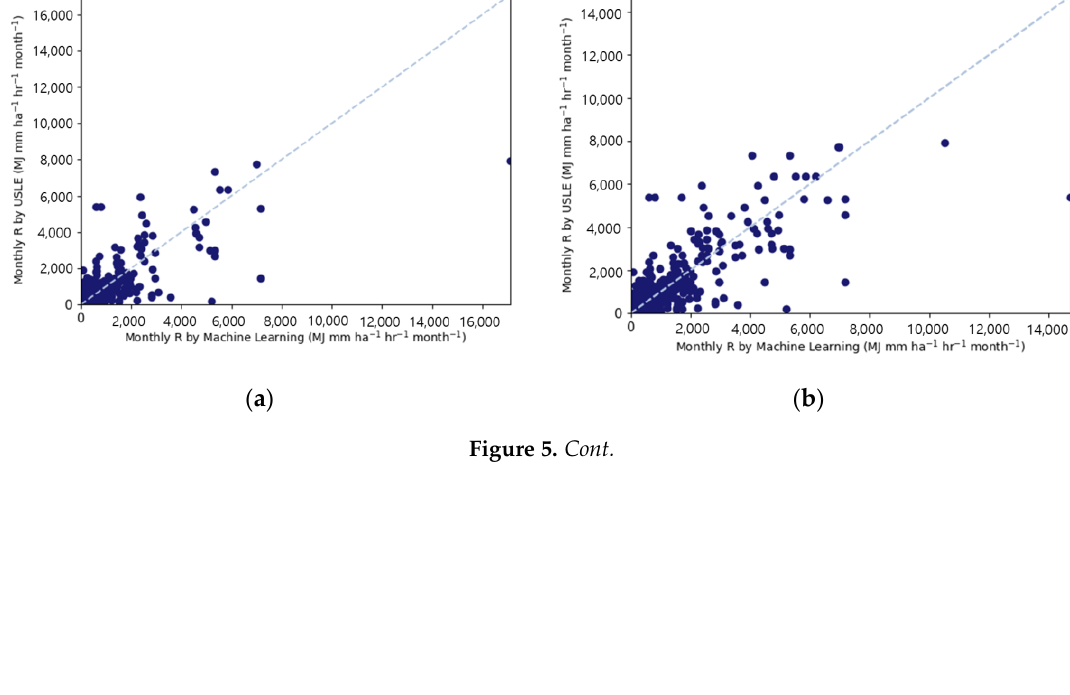
Table 5. Prediction accuracy results of seven machine learning models.